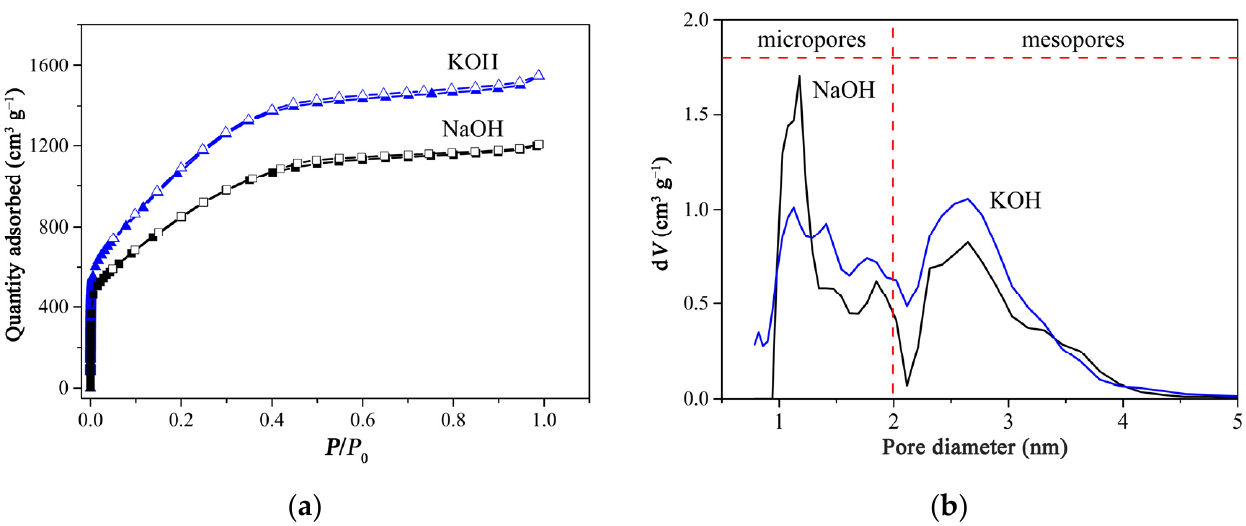
Figure 2. ( a ) N 2 adsorption/desorption isotherms and ( b ) pore size distribution curves of porous carbon products activated by KOH and NaOH, respectively.